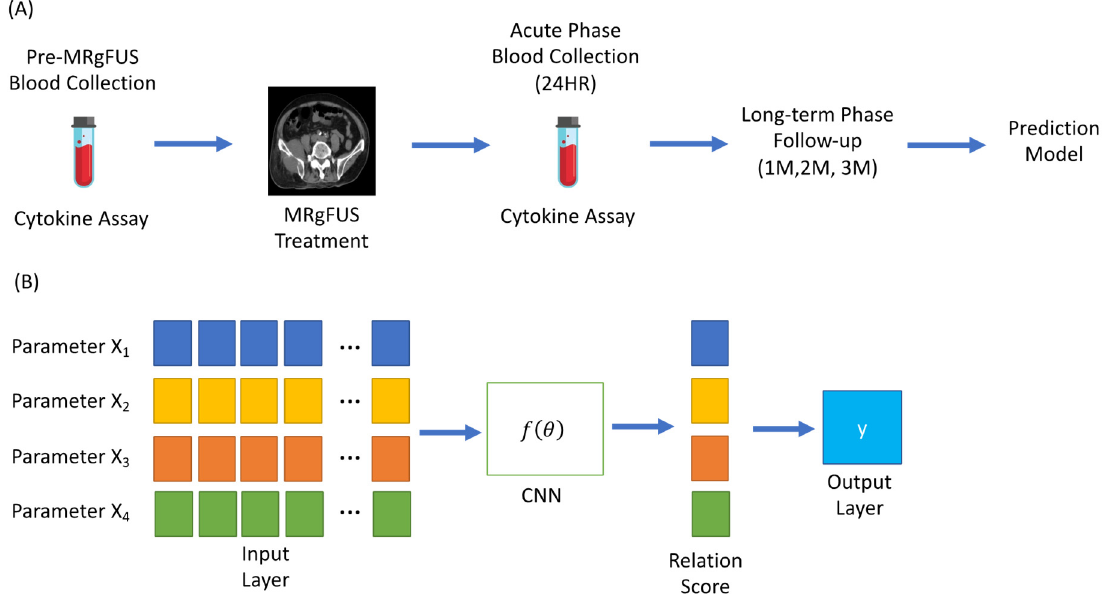
Figure 1. ( A ) Work flow of cytokine parameter collection; ( B ) schematic of few-shot learning approach for parameter classification.